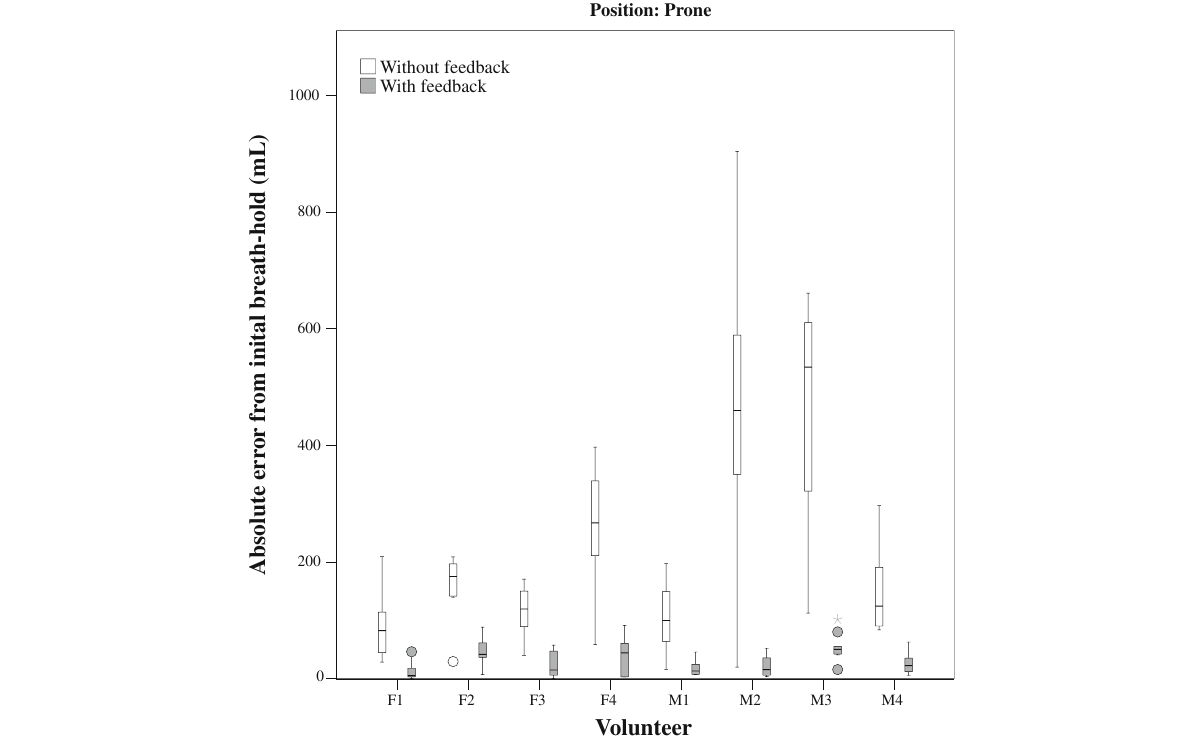
Fig. 9 Breath-hold error in prone position. Box plots of the error from initial breath-hold, without and with biofeedback, grouped by volunteer, in the prone